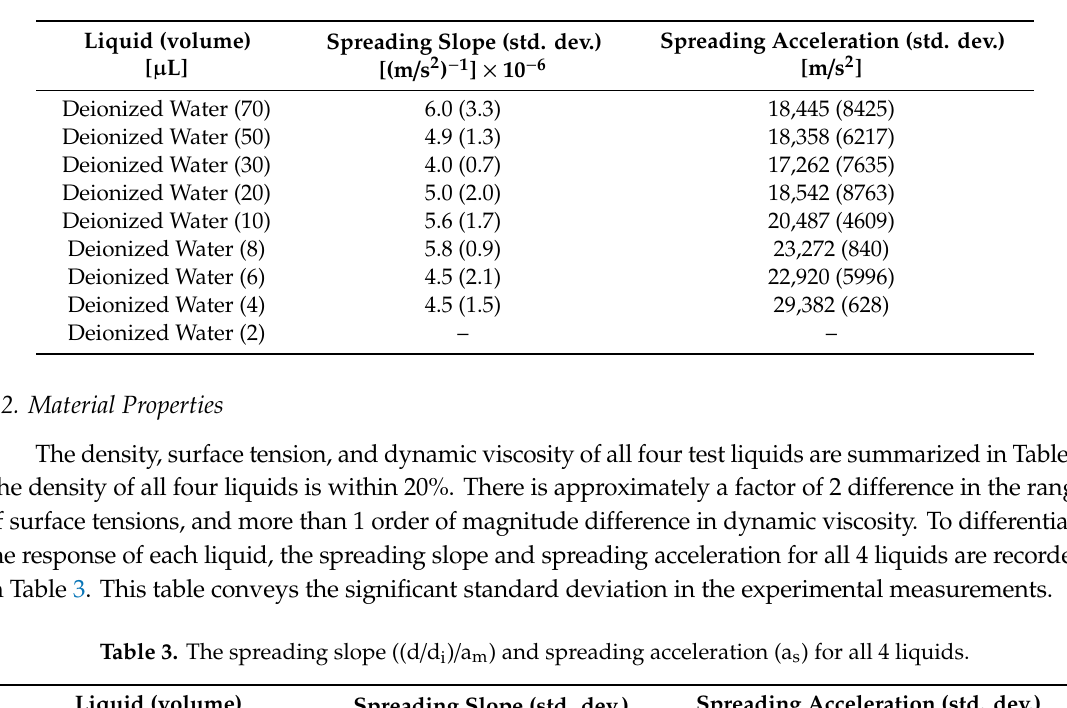
Table 2. The spreading slope ((d / d i ) / a m ) and spreading acceleration (a s ) for 2–70 µ L droplets of deionized water.